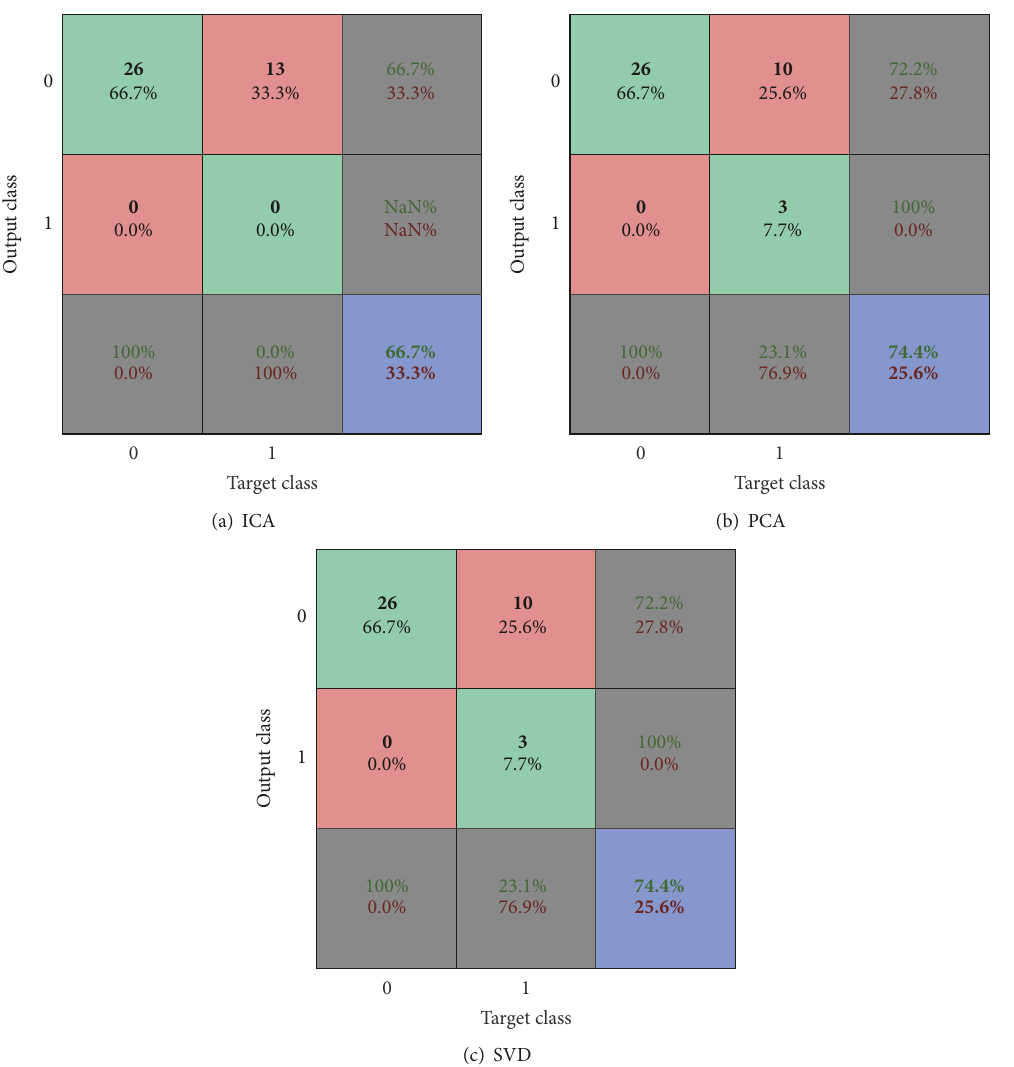
Figure 14: Confusion matrices of classification using CART for ICA, PCA, and SVD data reduction techniques.